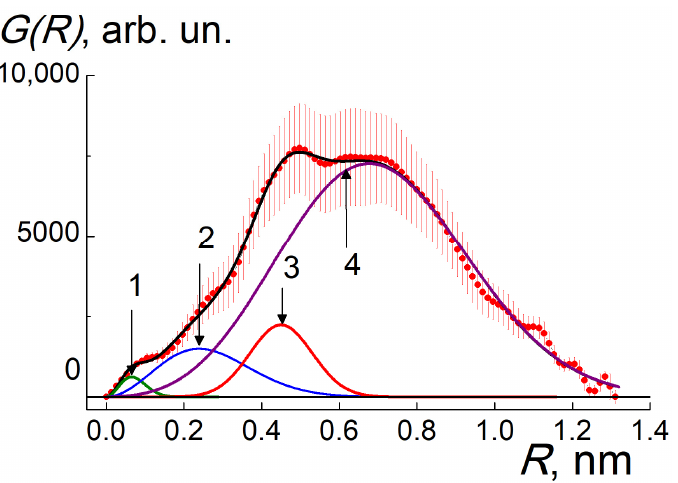
Figure 4. Distances distribution G(R) (dots) between scattering centers in pyrolyzate (carbon atoms, Eu-clusters, fragments of carbon shell around them) fitted with the function (1) (black line). Partial correlation functions 1-4 (lines) are plotted: 1 – green, 2 – blue, 3 – red, 4 – violet.